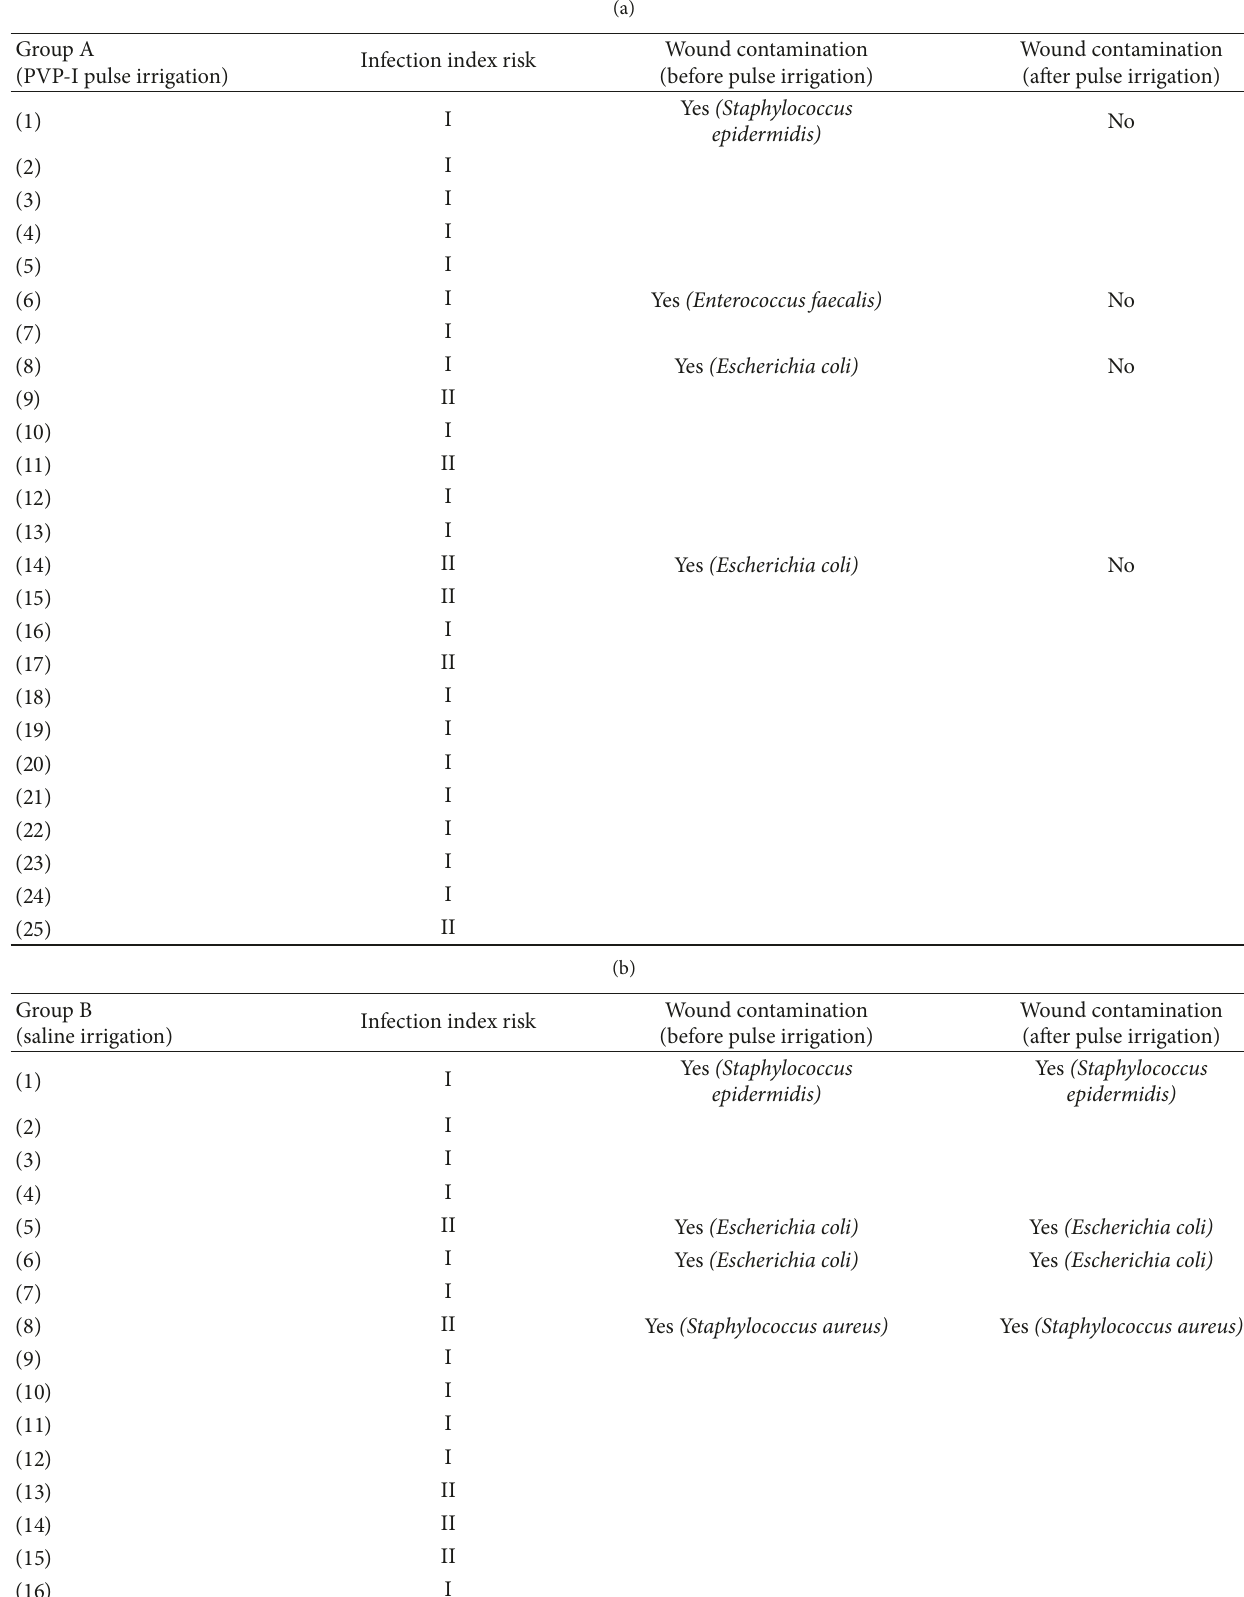
Table 3: List of two-group patients’ IRI score and wound